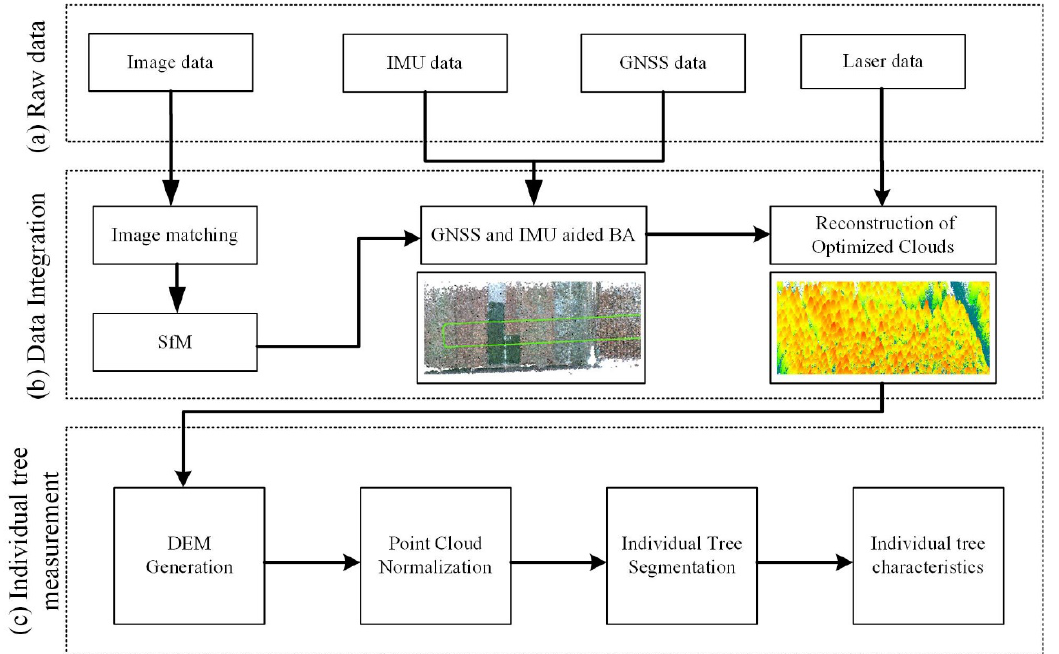
Figure 4. Workflow of the proposed method.